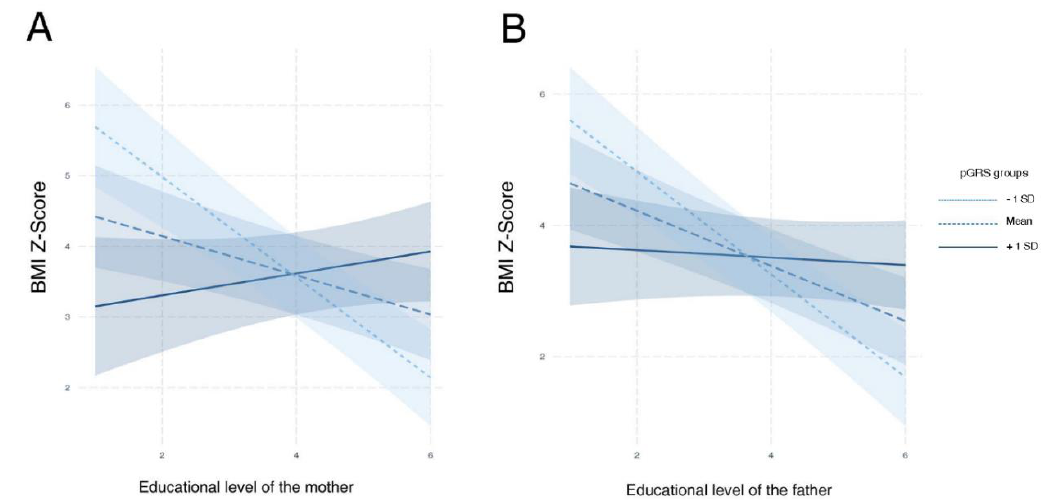
Figure 4. Interaction plots for observed significant modulatory e ff ects of environment over inherited genetic susceptibility to obesity (pGRS-environment interactions) in study population 1; these analyses were adjusted for the origin and pubertal status of children. ( A ) shows the modulatory e ff ect of the educational level of mothers over the pGRS-BMI Z-Score association. ( B ) shows the modulatory e ff ect of the educational level of fathers over the pGRS-BMI Z-Score association. In both subfigures, the pGRS is categorized according to the cut o ff values − 1 standard deviation and + 1 standard deviation. Abbreviations: BMI, body mass index; SD, standard